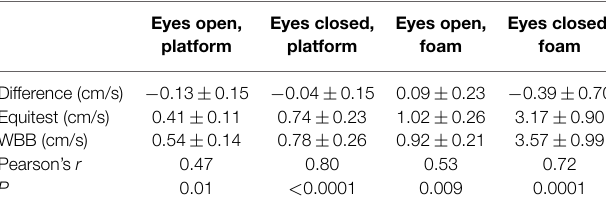
TABLE 2 | Means (cid:6) SDs of XY velocity values obtained on the Equitest platform and on the WBB; and mean (cid:6) SD of the difference (Equitest value – WBB value)